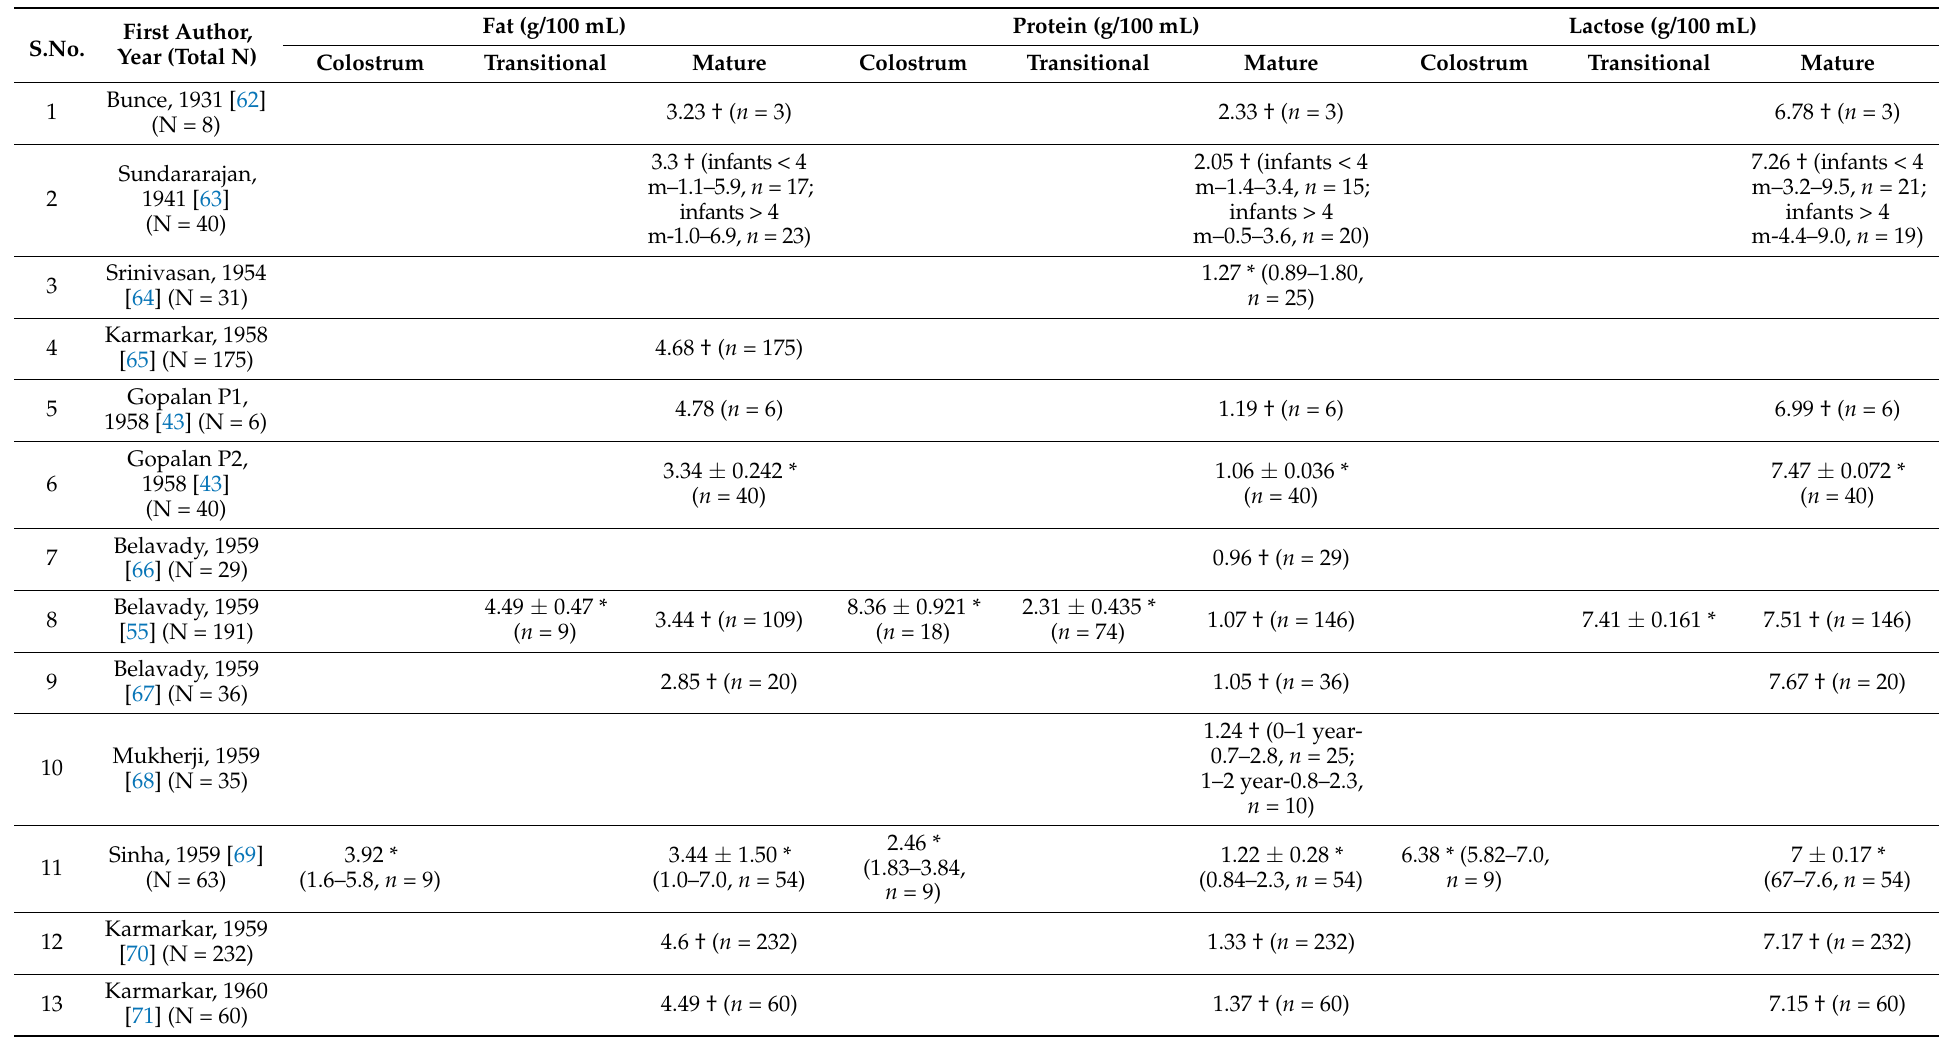
Table 1. Details of macronutrient content in colostrum, transitional and mature milk by various records ( n = 34).